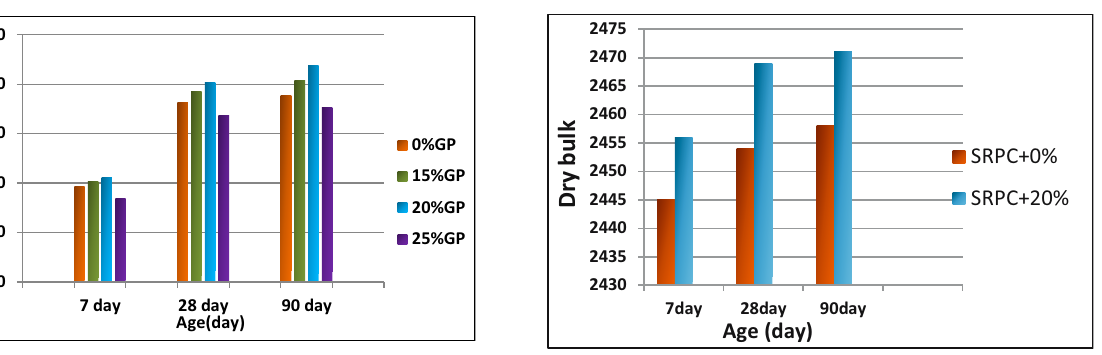
Figure 7: Relationship between the dry bulk density ( kg/m 3 ) and age ( day )